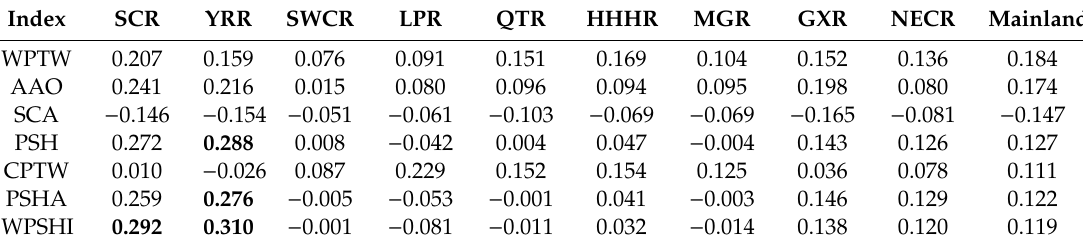
Table 5. The correlation between the SPEI and atmosphere